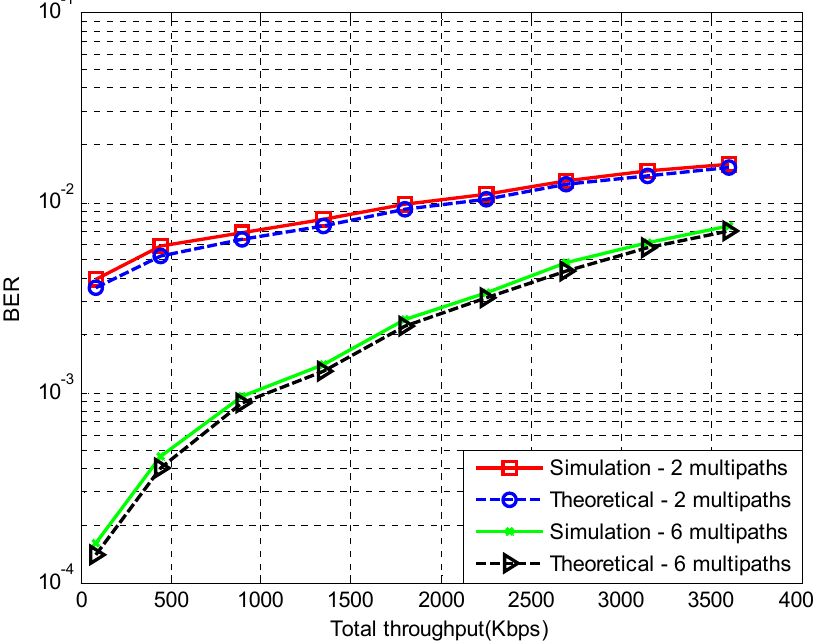
Figure A3 . Simulation and theoretical BER for a 4 × 3 MIMO—WCDMA network.